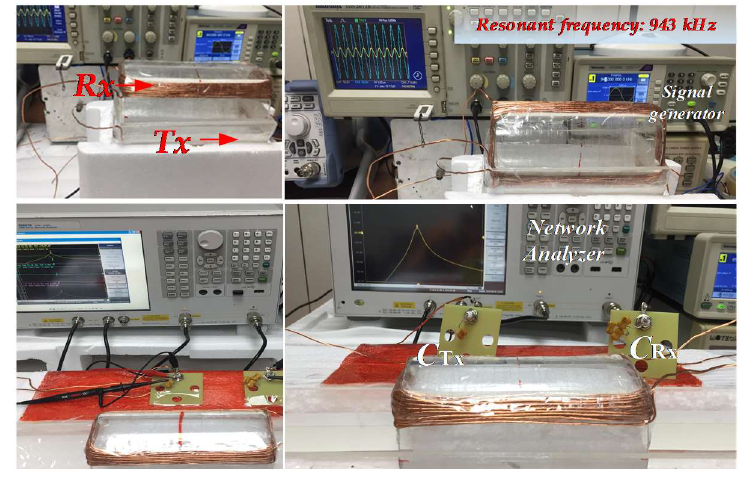
Figure 12. Experiment setup of WPT system. Table 1. Measured parameters.